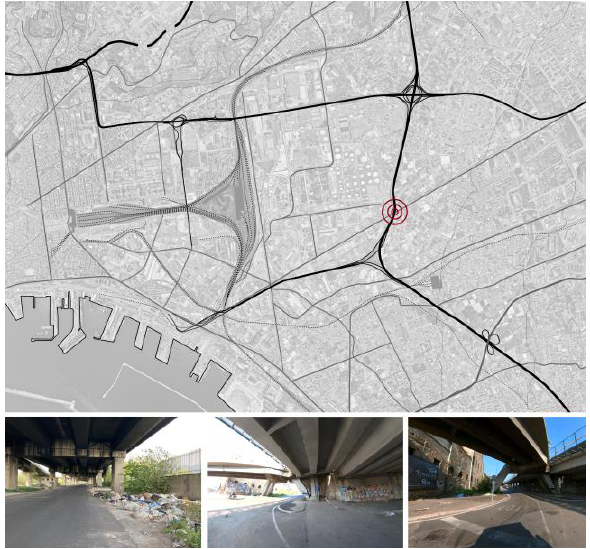
Figure 1 . Urban infrastructure network of the B-ROAD project. In red the road node under